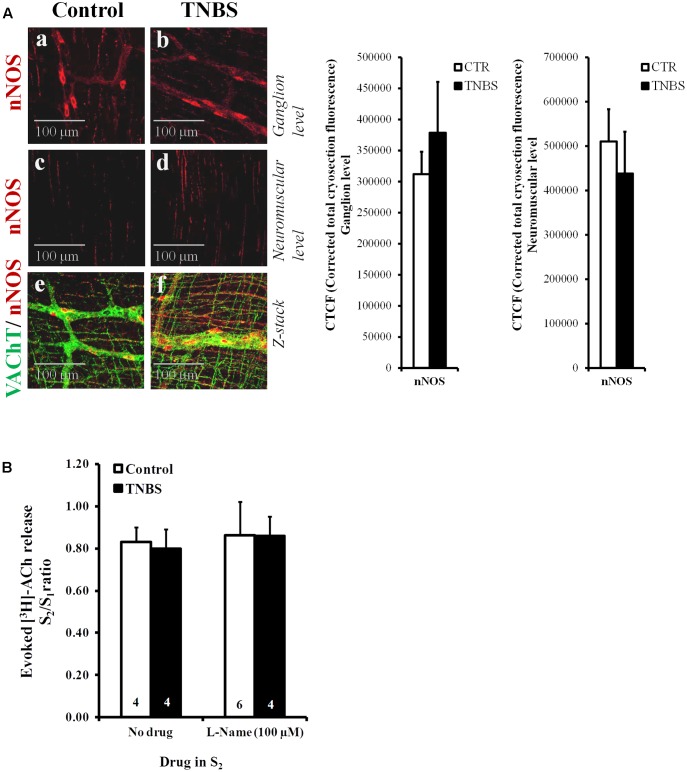
(A) Confocal micrographs of whole-mount preparations of the longitudinal muscle-myenteric plexus of the ileum from control and TNBS-treated rats taken at the myenteric ganglion level (a,b) and at the longitudinal smooth muscle layer (c,d). Shown is the immunoreactivity against neuronal NOS (nNOS). Z-stacks presented in panels (e) and (f) show that nNOS-positive nitrergic nerve fibers (red) are adjacent, but do not co-localize, with VAChT immunoreactivity (green). Images are representative of at least four individuals per group. Scale bar = 100 μM. Bar charts at the right hand-side panel represent mean ± SEM of corrected total cryosection fluorescence (CTCF) nNOS staining detected at the ganglion level and at the neuromuscular region. (B) Effect of the nitric oxide synthase (NOS) inhibitor, L-Name (100 μM), on [3H]ACh released from stimulated myenteric neurons of the ileum of control and TNBS-treated rats. After loading and washout periods, [3H]ACh release was elicited by two trains (S1 and S2) of electrical field stimulation, each consisting of 200 pulses delivered at a 5 Hz frequency. L-Name (100 μM) was applied 8 min before S2. The ordinates are changes in S2/S1 ratios compared to the S2/S1 ratio obtained without addition of any drug. The data are means ± SEM of four to six individuals.